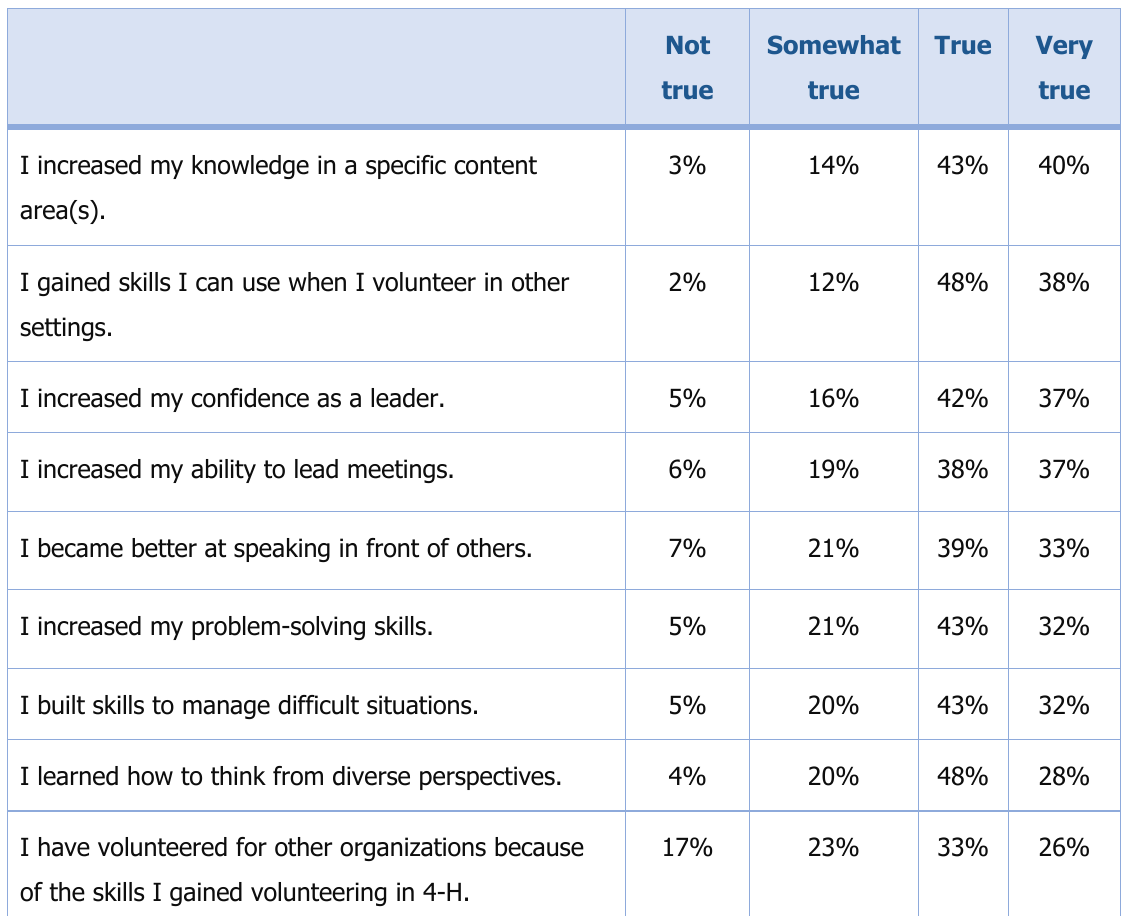
Table 3. Personal Skill Benefits